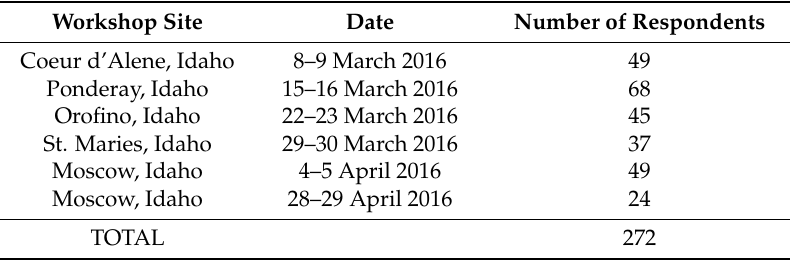
Table 1. Number of survey respondents, by Idaho Logger Education to Advance Professionalism (LEAP) workshop site and